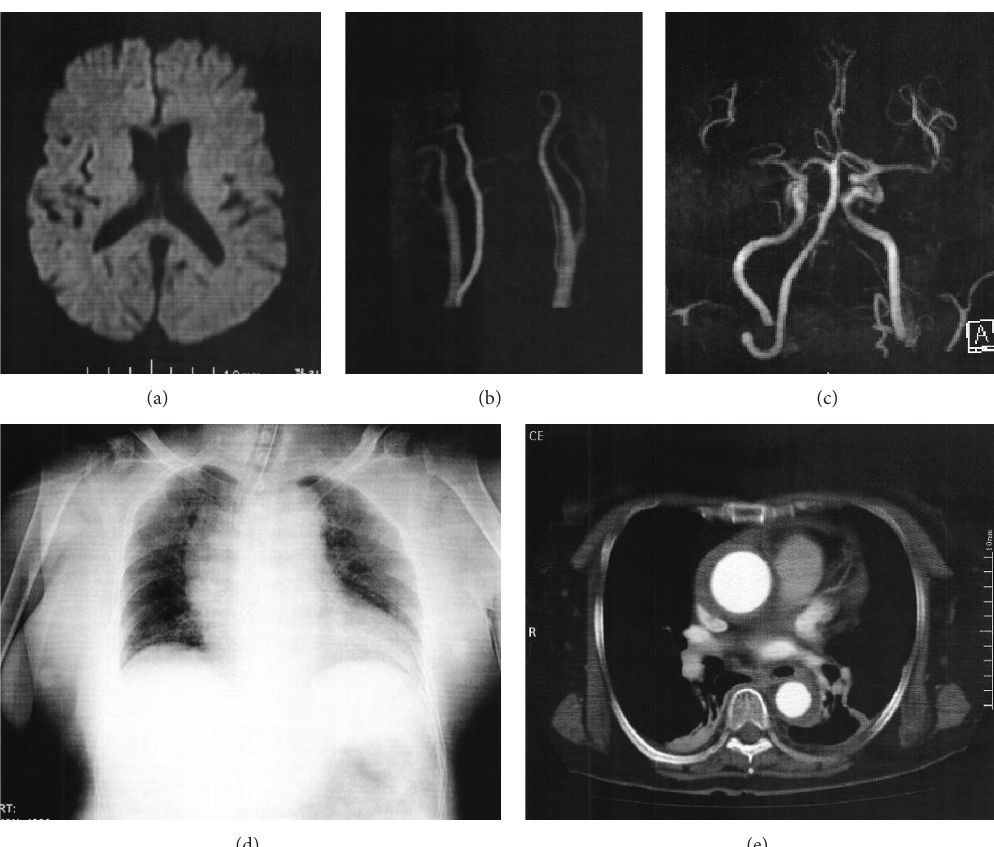
Figure 2: Axial head MRI-DWI (a), carotid MR angiography (b), head MR angiography (c), chest radiography (d), and axial chest to abdominal enhanced CT (e). Her pseudolumen had already been thrombosed and